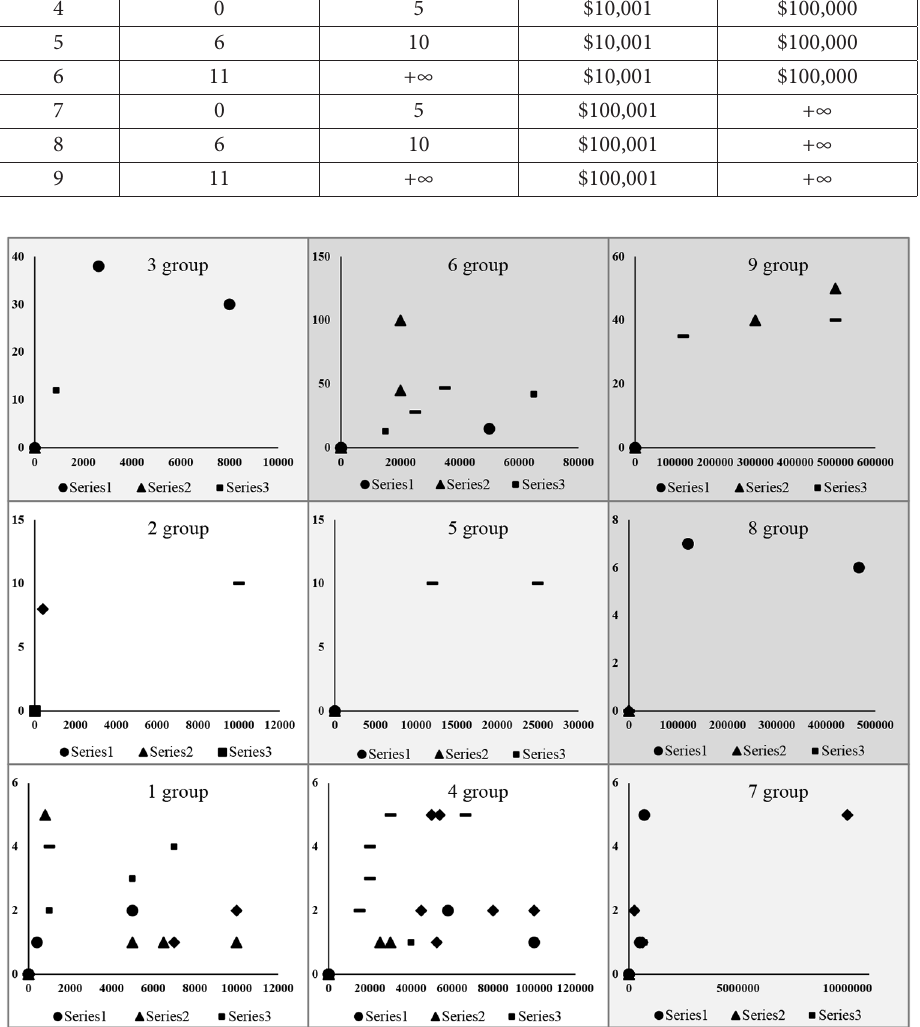
Figure 1. Classification of factors forming five risk incidents into nine groups (source: compiled